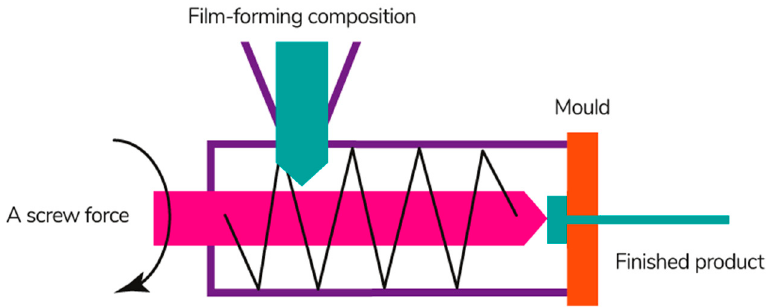
Figure 12. Extrusion process [186]. Reproduced with permission from Suhag, R., et al., Food Research International; published by Elsevier Ltd., 2020.